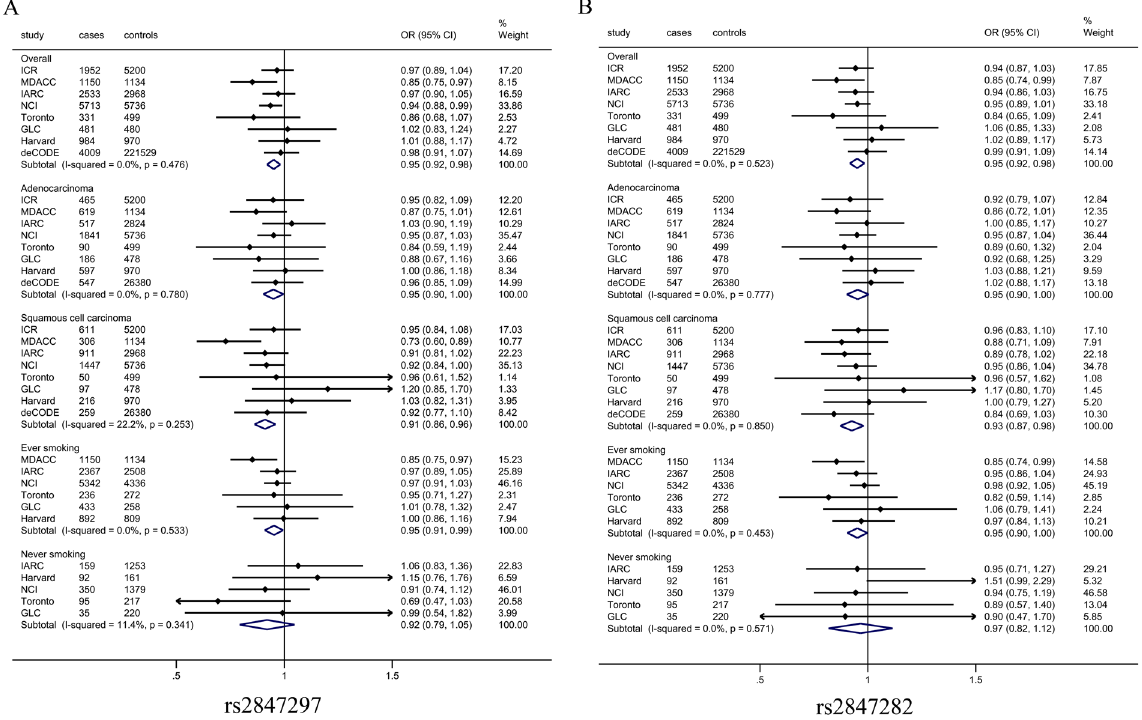
Figure 3. Forest plots of effect size and direction for tagSNPs from TRICL-ILCCO consortium. PTPN2 rs2847297 P combined = 0.004 in all individuals; P combined = 0.052 in overall adenocarcinoma individuals; P combined = 0.002 in overall squamous cell carcinoma individuals; P combined = 0.042 in overall ever smoking individuals; P combined = 0.465 in overall never smoking individuals ( A ); PTPN2 rs2847282 P combined = 0.009 in all individuals; P combined = 0.114 in overall adenocarcinoma individuals; P combined = 0.016 in overall squamous cell carcinoma individuals; P combined = 0.066 in overall ever smoking individuals; P combined = 0.960 in overall never smoking individuals ( B ); Each box and horizontal line represent the OR point estimate and 95% CI derived from the additive model. The area of each box is proportional to the statistical weight of the study. Diamonds represent the ORs obtained from the combined analysis with 95% confidence intervals indicated by their widths. The meta-analysis includes eight GWAS studies [the Institute of Cancer Research (ICR) GWAS, the MD Anderson Cancer Center (MDACC) GWAS, the International Agency for Research on Cancer (IARC)